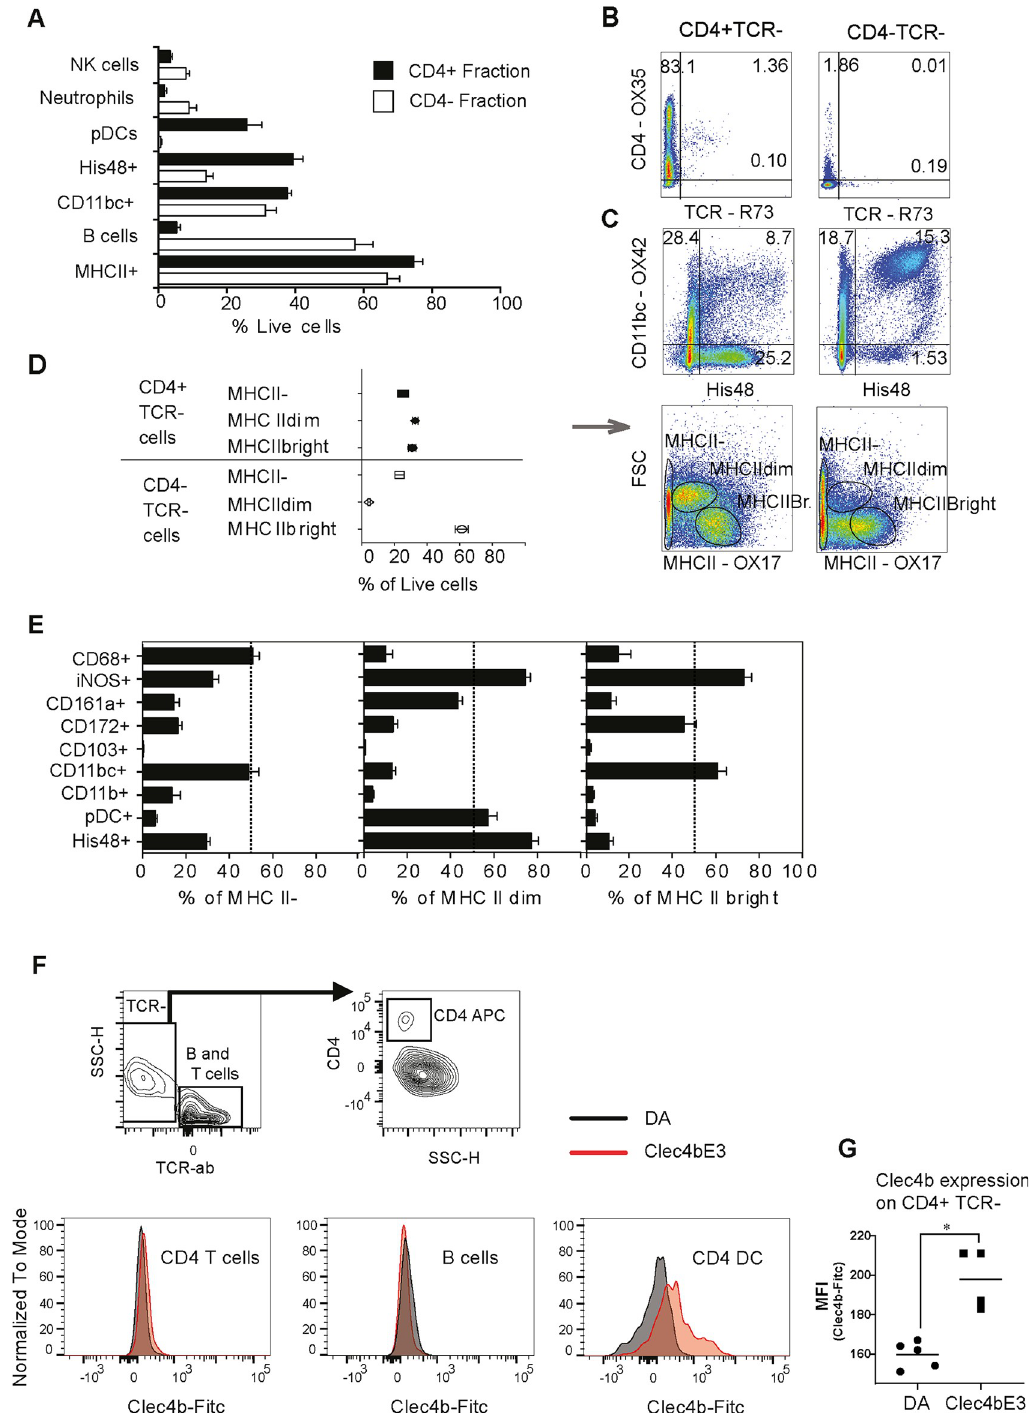
Fig 3. Clec4b is expressed in CD4+ MHCII+ DCs in two distinct sub-populations that are either MHCIIhi classical dendritic cells or MHCIIdim pDCs. a) Frequencies of florescence labeled cells (n = 8 for all groups), first selected to be TCR-, and after a second sorting separated into either CD4 + or CD4 - fractions using a CD4 antibody coated beads. NK cells are CD161hi, Neutrophils are His48+ and CD11b/c+, pDC are CD4+ and (CD45R) His24 + , B cells are CD45RA + (OX33), CD11b/c cells are OX42 + and His48 cells are granulocytes. b-d) Antibody labeled cell frequencies for CD4 + and CD4 - fractions in the total mononuclear cell population. b) Shows CD4 and TCR (clone R73) expression. c) Expression of CD11b/c and His48. d) Illustrate MHCII + expression (clone OX17) separated by cellular size by the forward scatter, and the three populations identified are also